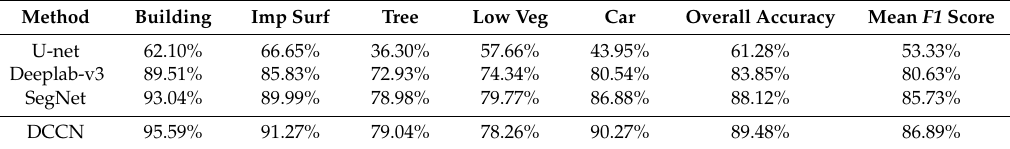
Table 4. IoU results between the proposed DCCN and several typical models.